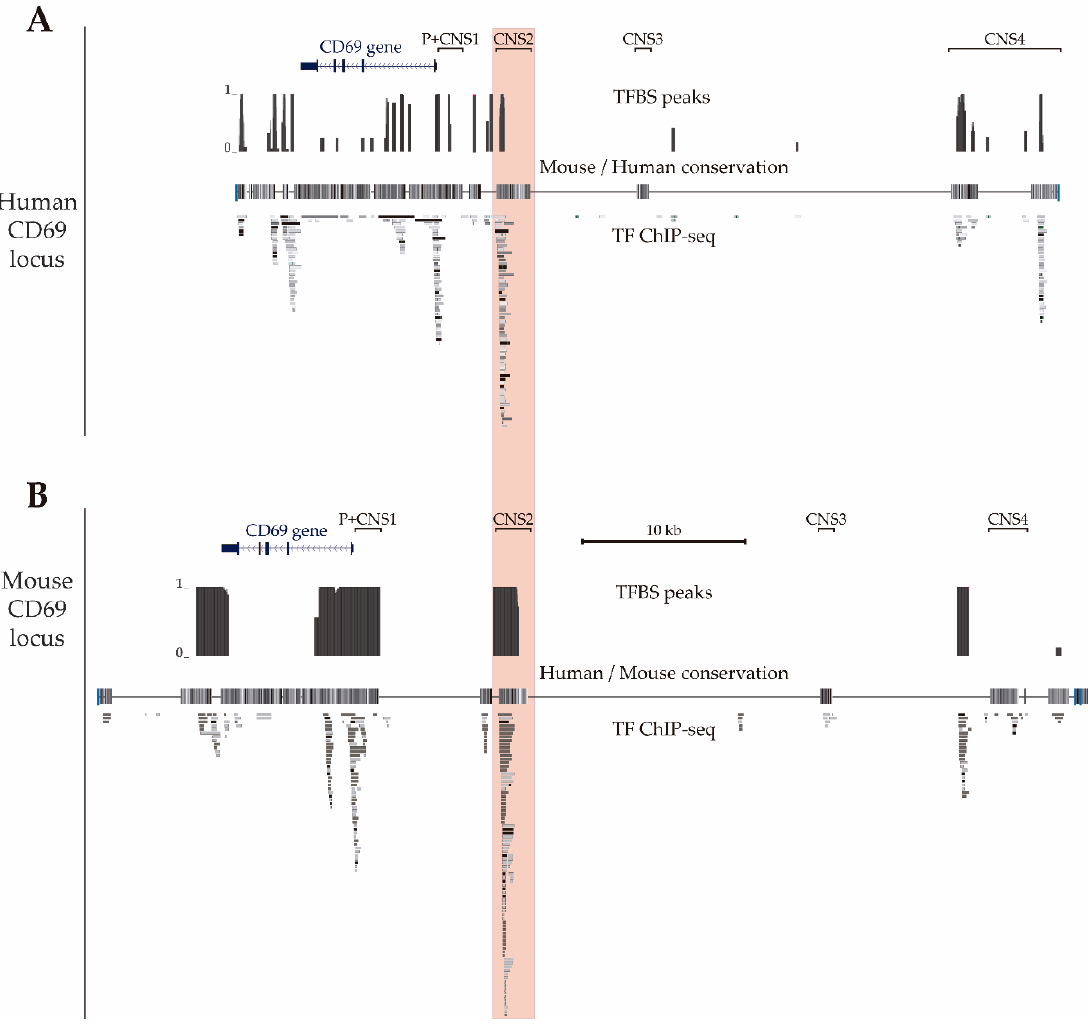
Figure 2. CD69 gene locus. UCSC genome browser showing the human ( A ) (GRCh37 / hg19 assembly, chr12: 9,900,752-9,952,771) and mouse ( B ) (GRCm38 / mm10 assembly, chr6: 129,259,289–129,321,308) CD69 locus and the four upstream conserved noncoding regions (CNS1-4). The alignment of the mouse and human genomes are displayed as a grayscale density plot that indicates the alignment quality, where darker values indicate higher levels of overall conservation. Transcription factor binding site peaks (TFBS peaks) show the proportion (between 0 and 1) of ChIP-seq data sets reporting TF binding at each location. The grey boxes represent di ff erent transcription factors found by ChIP-seq in human cell lines H1-hESC, A549, GM12878, HeLa-S3, IMR90, K562, HepG2, MCF-7, SK-N-SH, SK-N-SH_RA, HUVEC, AG04449, AG04450, AG09309, AG09319, AG10803, AoAF, BE2_C, BJ, Caco-2, Dnd41, ECC-1, Fibrobl, GM06990, GM08714, GM10847, GM12801, GM12864, GM12865, GM12872, M12873, GM12874, GM12875, GM12891, GM12892, GM15510, GM18505, GM18526, GM18951, GM19099, GM19193, GM19238, GM19239, GM19240, Gliobla, HA-sp, HAc, HBMEC, HCFaa, HCM, HCPEpiC, HCT-116, HEEpiC, HEK293, HEK293-T-REx, HFF, HFF-Myc, HL-60, HMEC, HMF, HPAF, HPF, HRE, HRPEpiC, HSMM, HSMMtube, HVMF, MCF10A-Er-Src, NB4, NH-A, NHDF-Ad, NHDF-neo, NHEK, NHLF, NT2-D1, Osteobl, PANC-1, PBDE, PBDEFetal, PFSK-1, ProgFib, RPTEC, Raji, SAEC, SH-SY5Y, SK-N-MC and T-47D (available at UCSC) and in mouse primary T CD4 + , T CD8 + and B lymphocytes (TF-ChIP-seq, available at ChIP Atlas and ChIP-Base